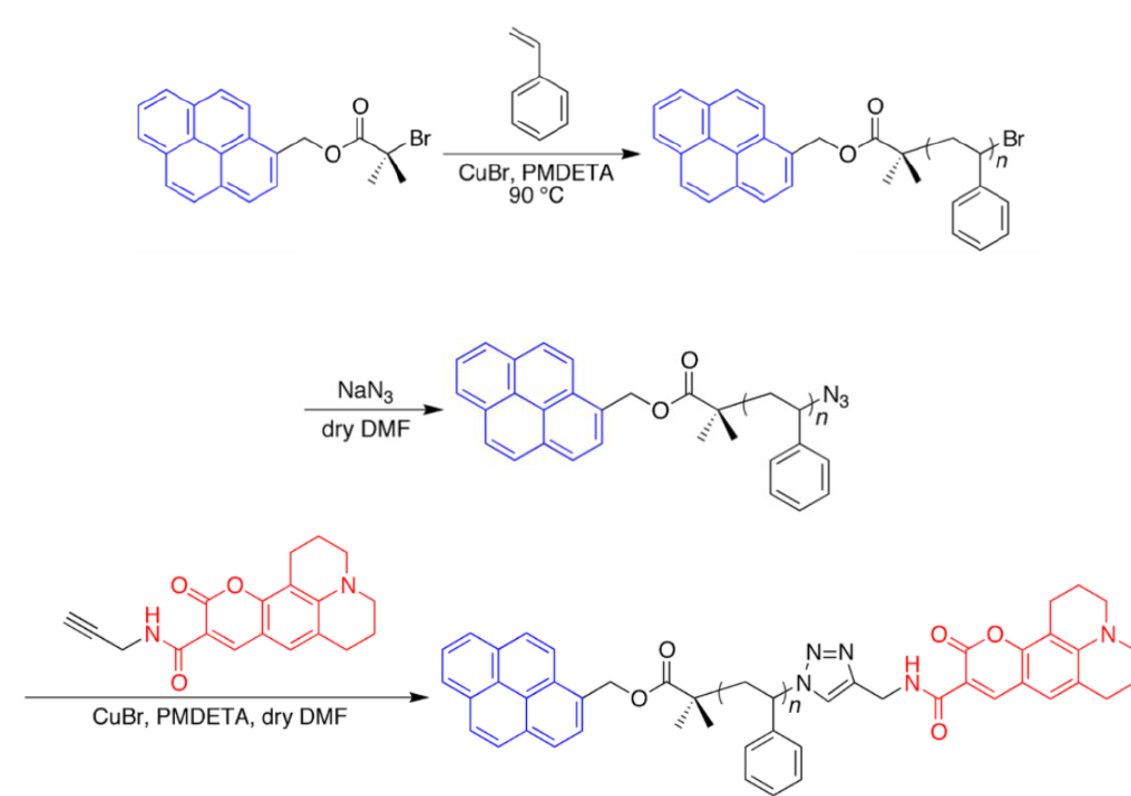
Figure 5. Synthesis of Pyr-PSt-C343 by ATRP-Click approach.